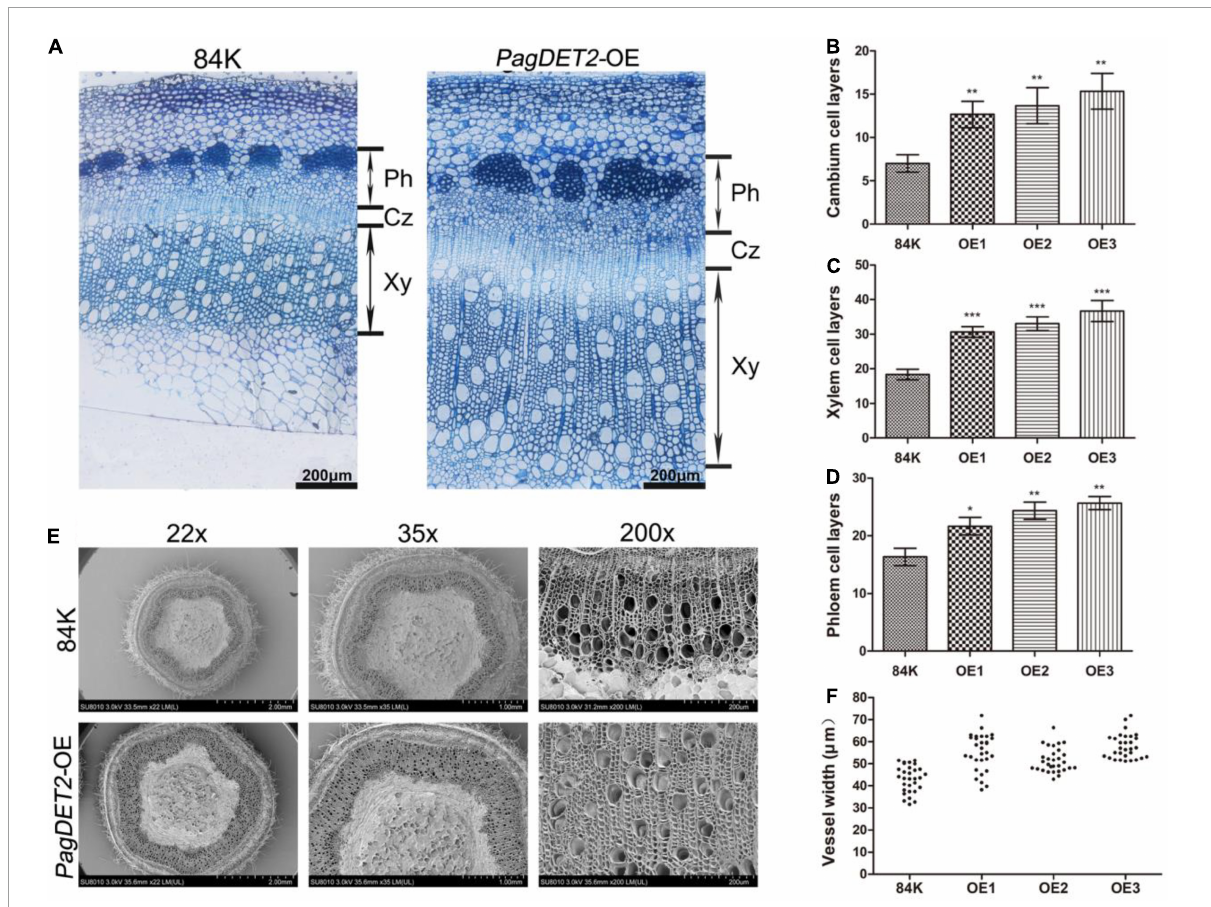
FIGURE4 The 60-day-old wild-type and PagDET2 overexpression lines anatomical observations and phenotypic statistics. (A) Toluidine blue stained cross-sections of the stem of 84K wild-type and PagDET2 overexpression lines, bar = 100 µ m. (B–D) The number of cambium cell layers, XY cell layers, and Ph cell layers of 84K wild-type and PagDET2 overexpression lines. (E) SEM observation of 84K wild-type and PagDET2 overexpression lines at different magnifications. (F) The vessel width of 84K wild-type and PagDET2 overexpression lines was counted under SEM, and the width of 30 vessels was counted. CZ, cambium zone; XY, xylem; Ph, phloem; SEM, scanning electron microscope. Mean ± SD. *, **, and *** showed significant difference at P < 0.05, P < 0.01, and P < 0.001, respectively (Student’s t